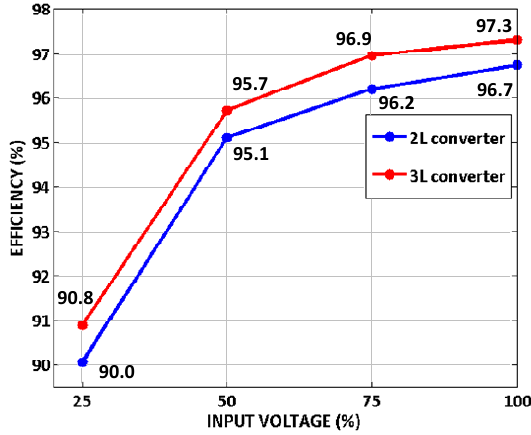
Figure 13. Efficiencies for 2L and 3L converters.